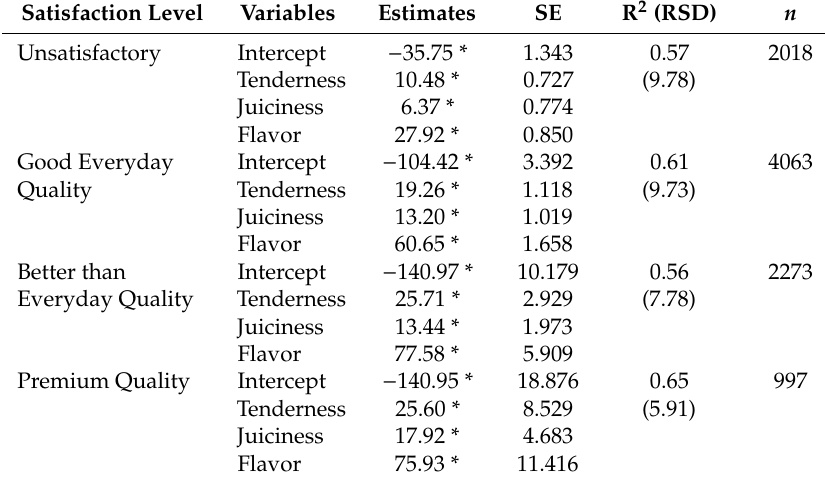
Table 13. Comparison of attribute levels of corresponding satisfaction levels.